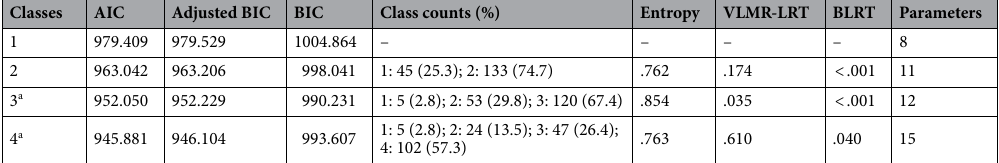
Table 4. The model fit information for the GMM models for depression and anxiety (N = 178). GMM Growth Mixture Model, AIC Akaike Information Criterion, BIC Bayesian Information Criterion, VLMR-LRT Vuong- Lo-Mendell-Rubin Likelihood Ratio Test, BLRT Bootstrap Likelihood Ratio Test. a The variance of the slope was fixed at zero for all